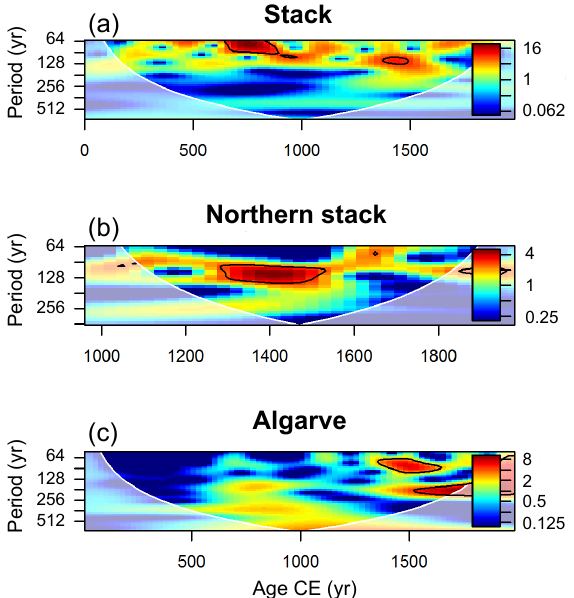
Figure 6. The continuous wavelet power spectrum of the SST stack (a) ; the north SST stack (b) ; and the Algarve SST record (c) . The thick black contour designates the 95% confidence level, and the lighter shaded area represents the cone of influence (COI) where edge effects might distort the results.